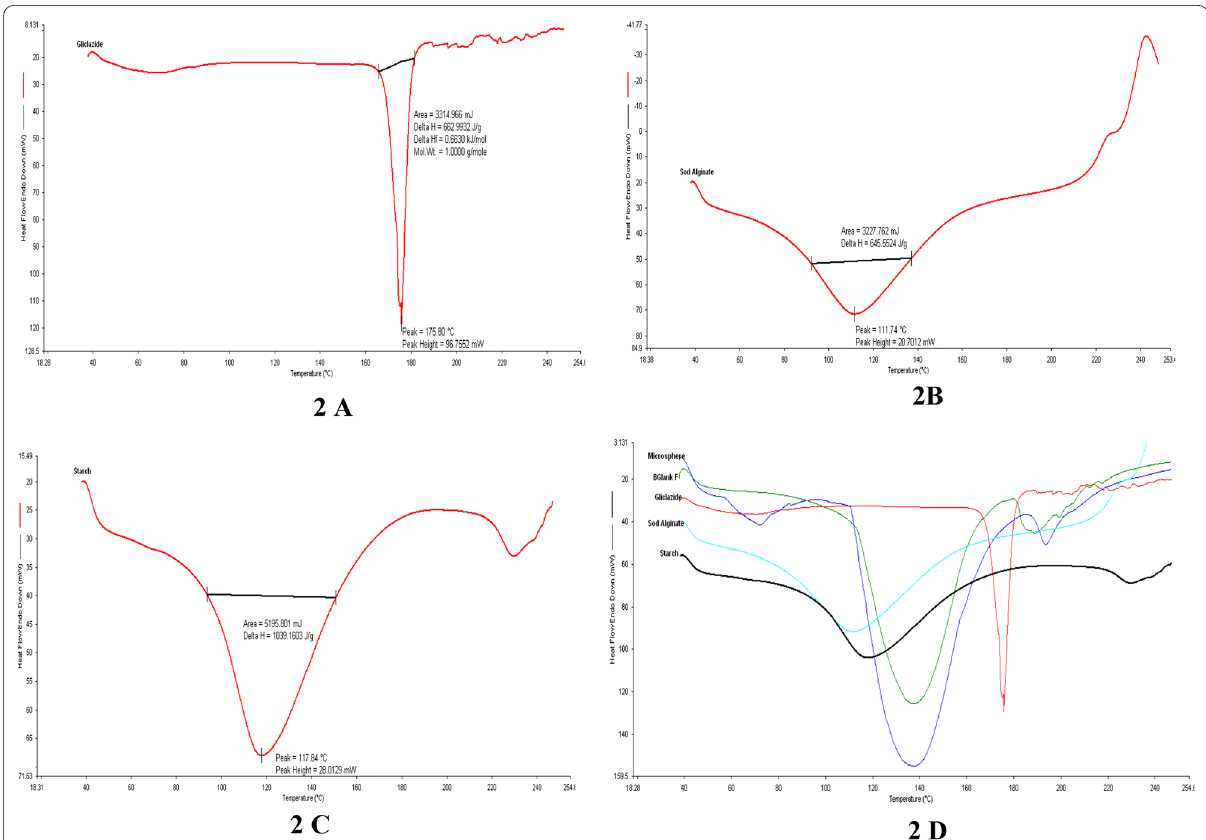
Fig. 2 The DSC thermogram is shown here A DSC thermogram of pure gliclazide B DSC thermogram of sodium alginate C DSC spectrum of starch obtained from Musa balbisiana species D DSC thermogram of Drug-loaded microsphere, blank microsphere, pure gliclazide, sodium alginate and starch